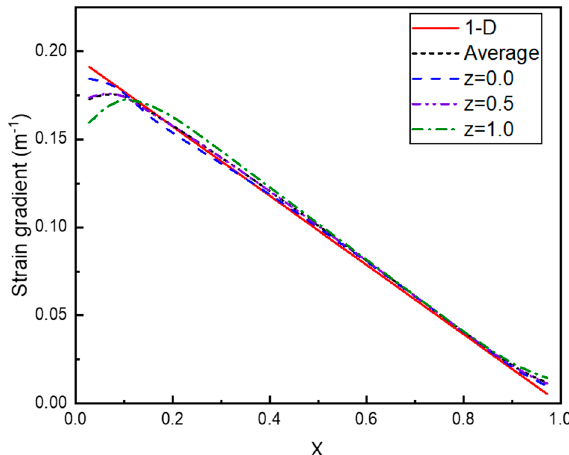
Figure 6. Strain gradient distributions along the x axis on the upper surface of the element for δ = 7.5 µ m.